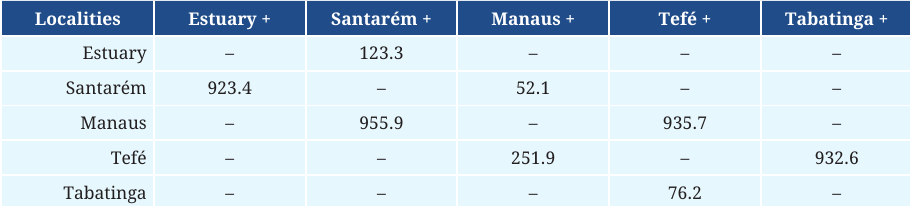
TABLE 3 | Estimates of effective number immigrating individuals per generation for Brachyplatystoma vaillantii . Source population are in the row, recipient population in the columns. The signal “+” represents receiving localities. The signal “–” represents without comparison. Migration was defined between adjacent